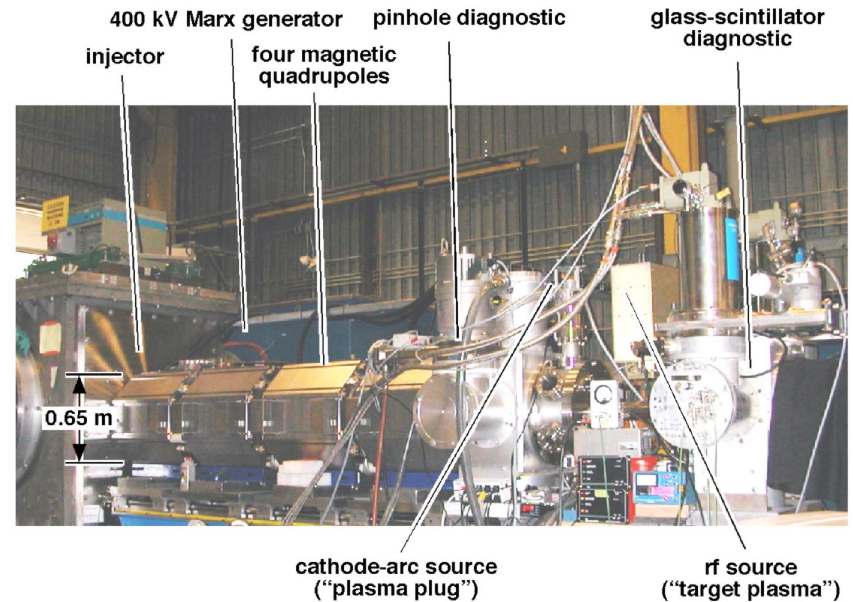
FIG. 1. (Color) Photograph of the neutralized-transport experiment